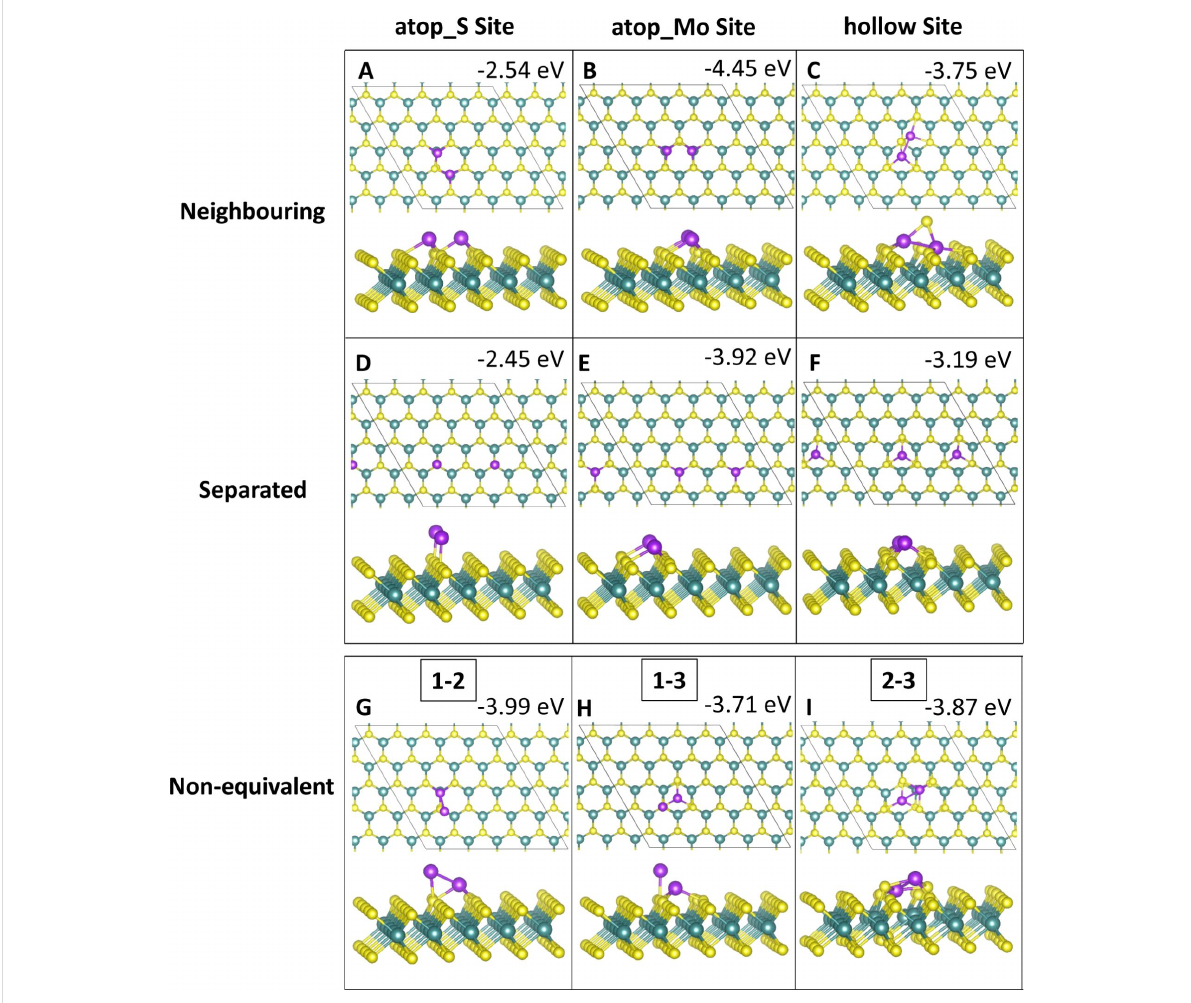
Figure 4: Atomic structure and energies of Ru 2 adsorption modes on perfect MoS 2 .